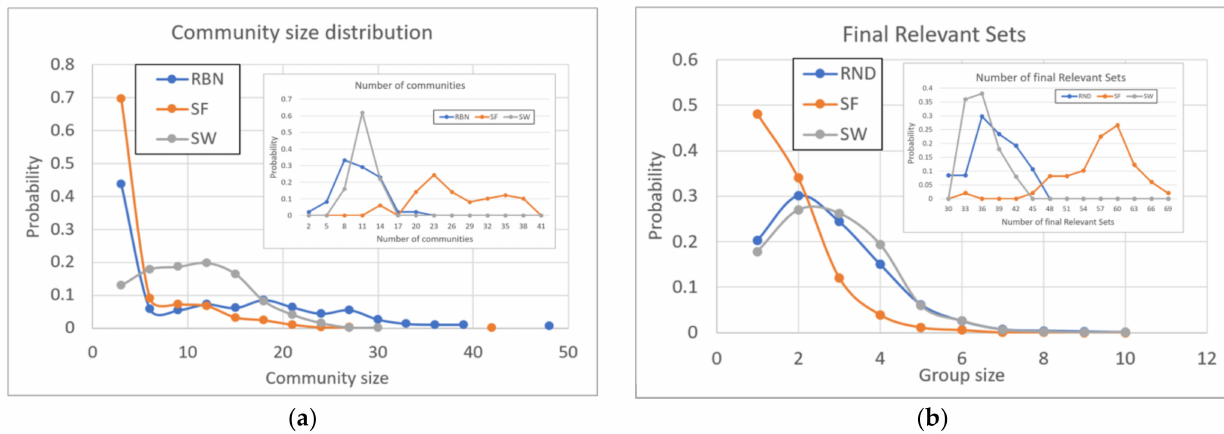
Figure 6. Results of the static and dynamic analyses. ( a ) Distribution of the size of the communities in the zI-graph : these distributions are significantly different for the three different system types (inset: the distribution of the number of communities in the three types of systems). ( b ) Distribution of the size of the final RSs (inset: the distribution of the number of RSs in the three types of systems). The characteristics of the distributions in points ( a ) and ( b ), described in the text, are stable for a certain range of the main parameters of the algorithms, and substantially they do not change if the threshold of zI is increased from 3 to 4, nor if the discretization threshold Th is increased from 2 to 3 (data not